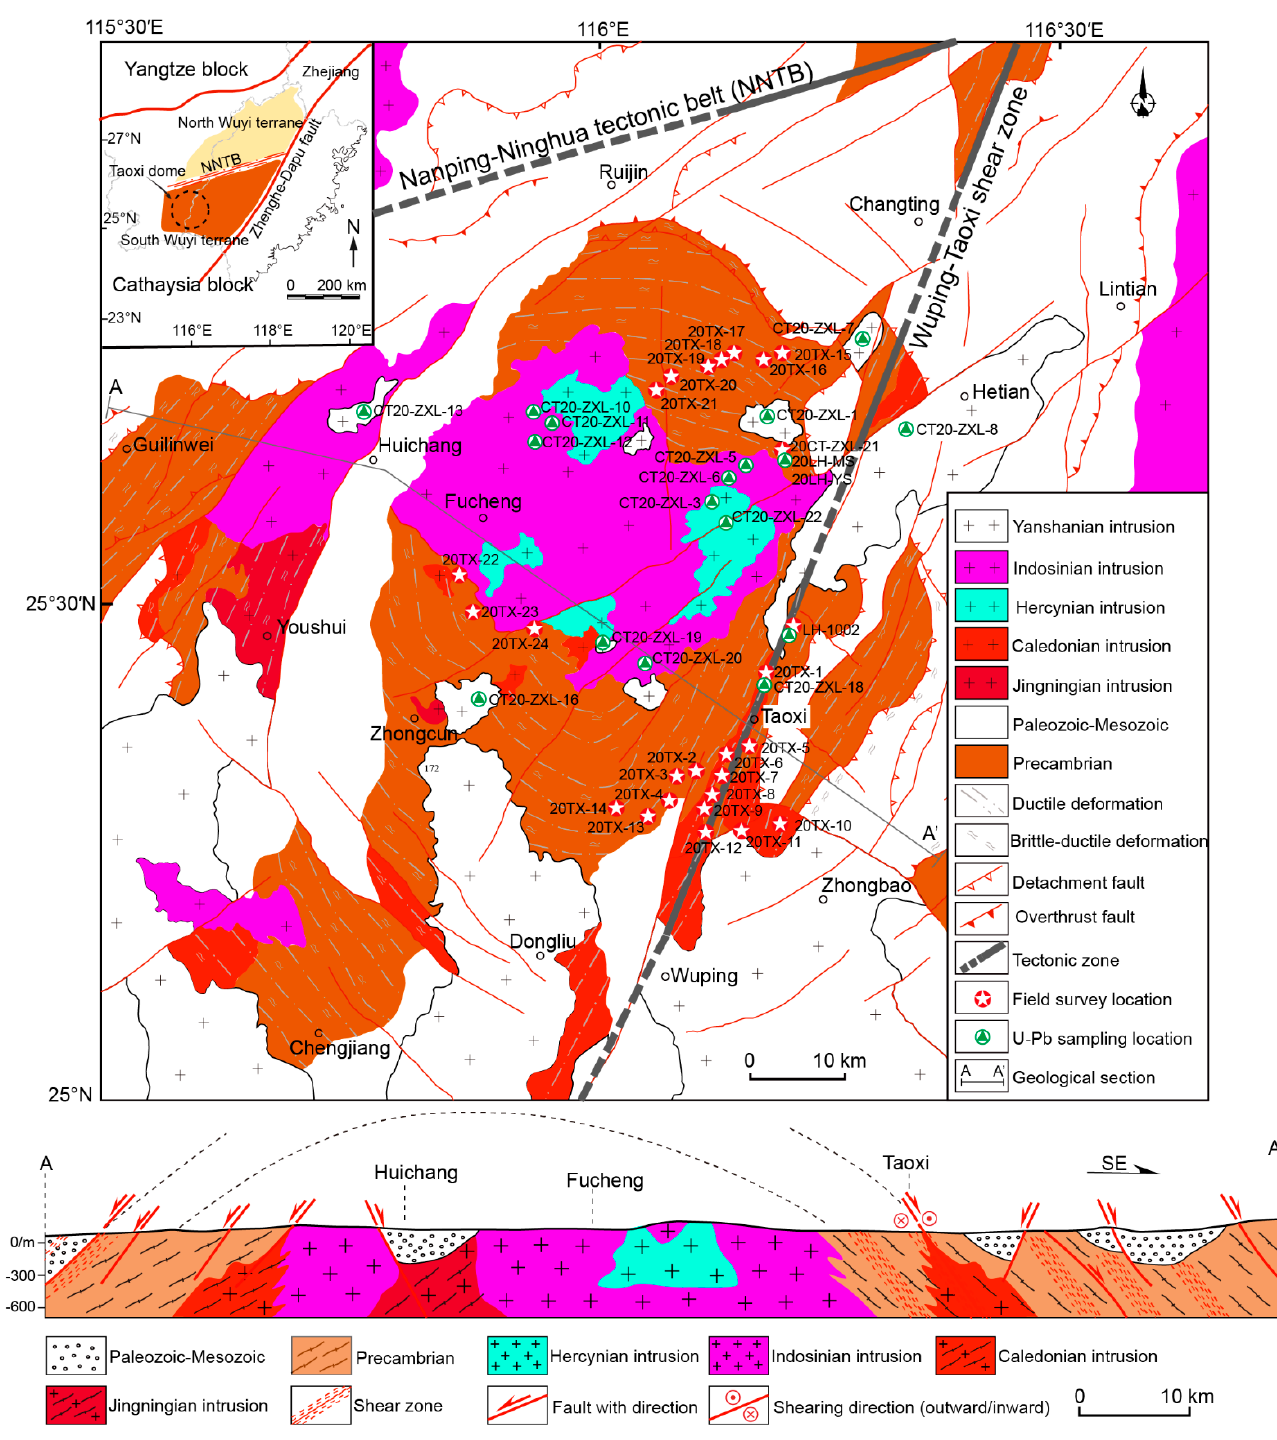
Figure 1. Simplified geological map of the Taoxi dome and the sampling locations. Note the tectonic setting of the Taoxi dome and the abbreviation of the Nanping–Ninghua tectonic belt (NNTB).